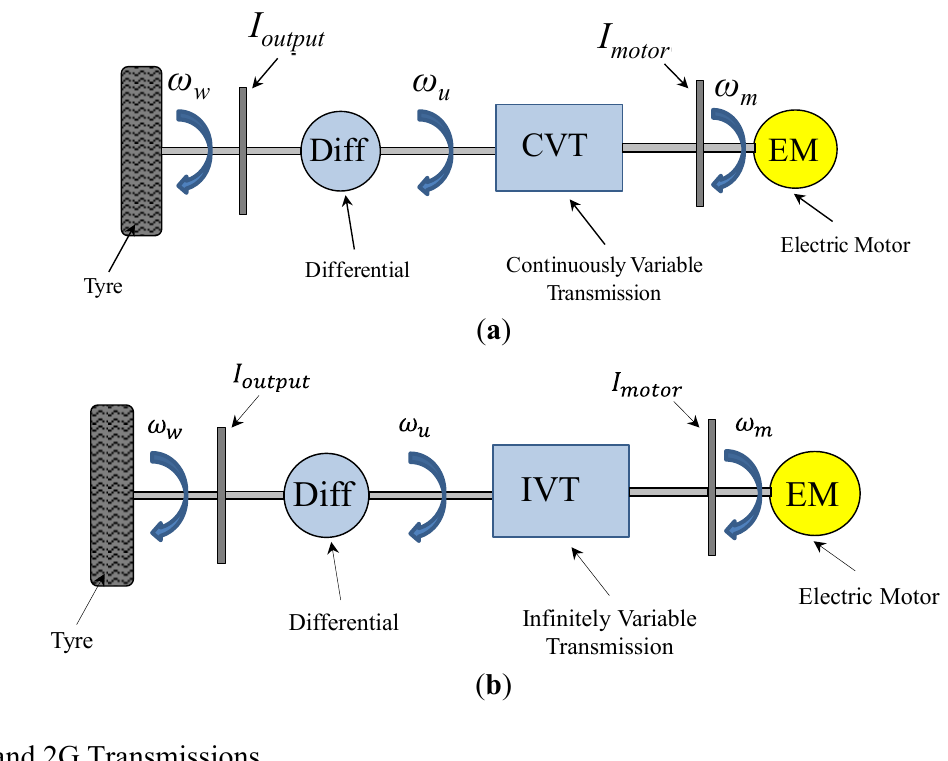
Figure 2. Vehicle layouts with ( a ) CVT and ( b ) IVT. ( a ) Schematic of the BEV with a CVT; ( b ) Schematic of the BEV with an